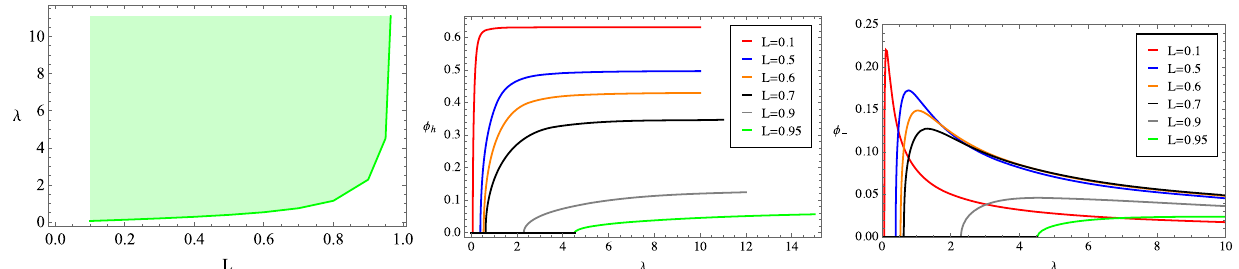
Fig. 6 Left: the threshold curves for AdS black hole with negative curvature; Middle: the scalar hair near the horizon as the function of (cid:3) with different AdS radius L ; Right: the corresponding scalar charge of the black hole φ − as the function of λ